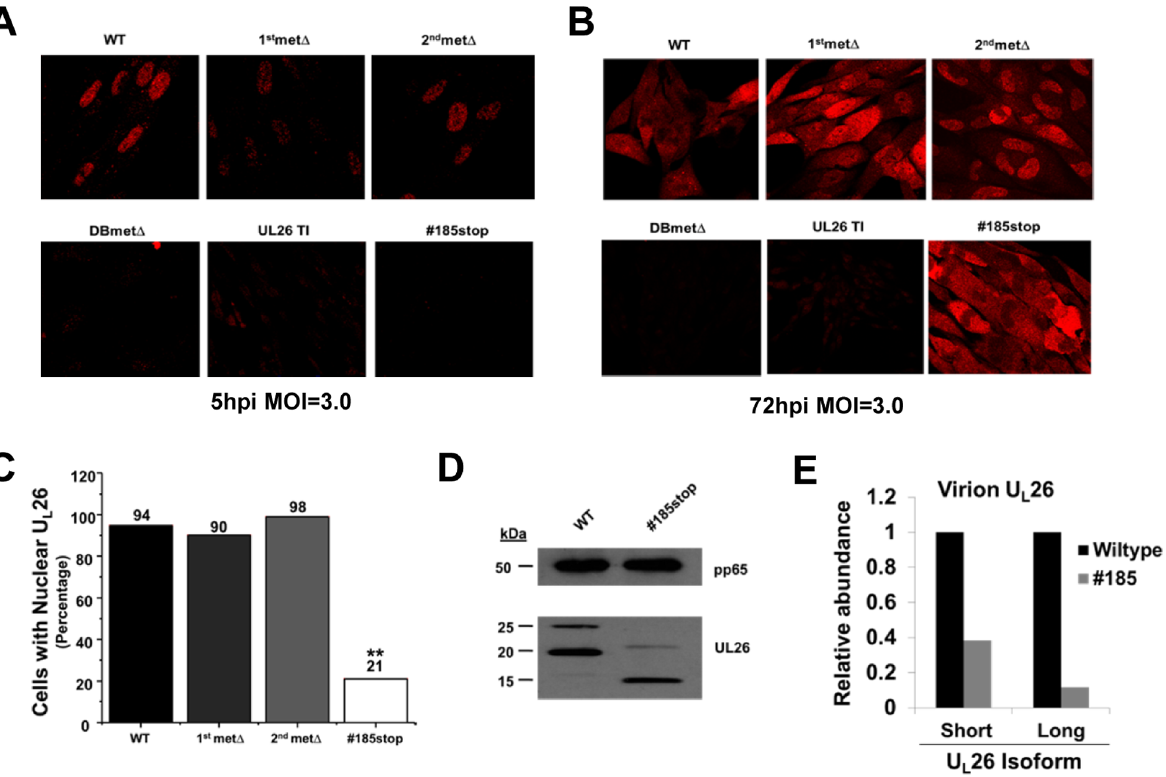
Figure 7. Localization of the U L 26 protein in HCMV infected cells. MRC5 fibroblasts were infected at an MOI of 3.0 and were fixed at either 5 hpi ( A ) or 72 hpi ( B ) and processed for immunofluorescence using an antibody specific for the C-terminus of U L 26. ( C ) Quantification of the cells containing nuclear localized U L 26 protein at 72 hpi. The percentage of total cells containing nuclear localized U L 26 was plotted. U L 26 localization in over one-hundred cells in separate fields was determined, ** p , 0.01 compared to WT virus. All counted cells contained detectable U L 26 expression. ( D ) U L 26 tegument protein composition of WT and # 185stop virus. Viral particles from the supernatants of MRC5 fibroblasts infected with either WT or # 185stop virus were separated from cell debris via low-speed centrifugation. Thereafter, the particles were purified by differential sedimentation in a glycerol-tartrate gradient. Resulting virion fractions were processed for Western blotting using U L 26 and pp65-specific monoclonal antibodies. ( E ) Quantification of tegument U L 26 protein in glycerol-tartrate purified virions. The amount of U L 26 protein present in virions ( D ) was quantified after normalization to the amount of virion pp65. Quantification of U L 26 and pp65 specific bands was performed using BioRad ImageLab software.